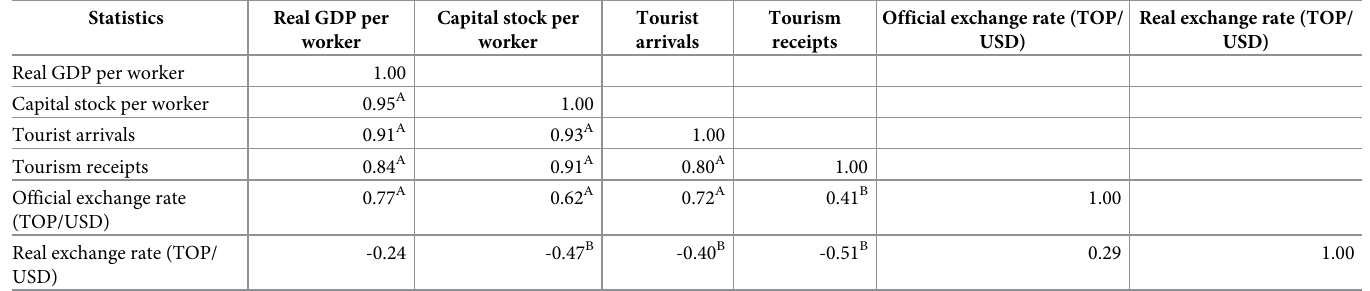
Table 2. Correlation matrix.